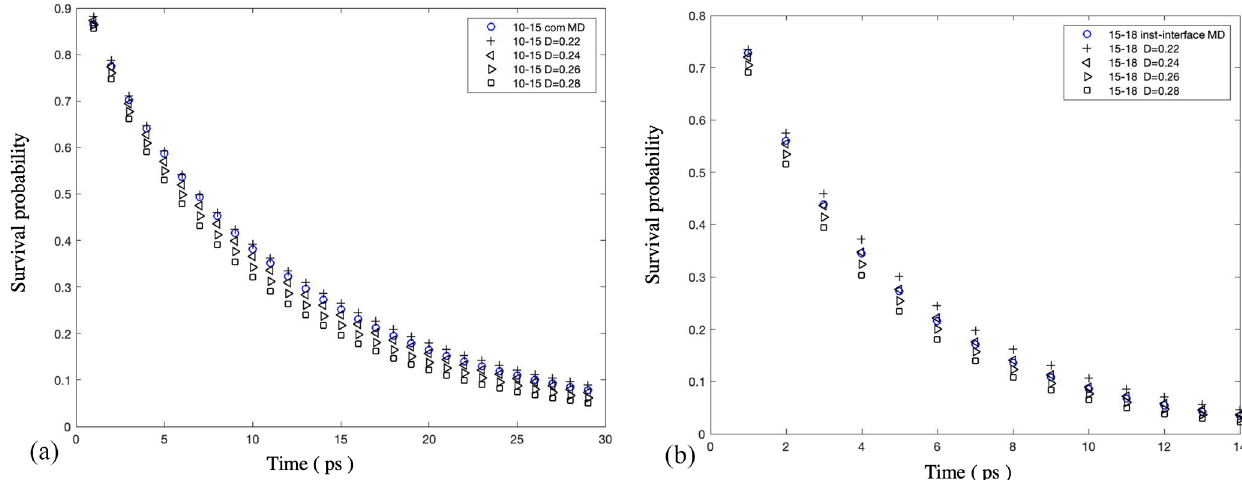
Figure A9. Validation of our numerical solution of the anisotropic Smoluchowski equation: (a) survival probability of water molecules as a function of time in a bulk-liquid-like water layer (with a distance from the Gibbs dividing surface of [1, 1.5]nm) in 5000 water droplets under the com scheme and (b) the same calculation for a bulk-liquid-like water layer (with a distance from the instantaneous interface of [1.5, 1.8]nm) under the inst scheme. The water diffusion coefficient perpendicular to the interface ( D ⊥ ) is calculated by optimizing the agreement between the water survival probability in MD simulations (blue circle) and the Smoluchowski prediction obtained with different D ⊥ values (black symbols). The results show that both schemes show consistent results for D ⊥ in bulk liquid droplet regions, with D ⊥ , bulk = (0 . 22 , 0 . 24)Å 2 ps − 1